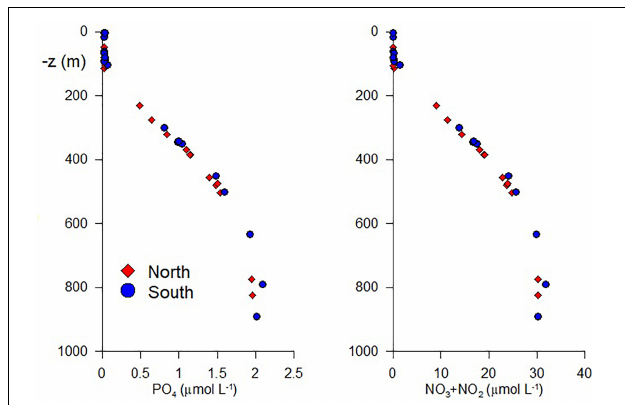
FIGURE 3 | Vertical profiles of inorganic dissolved nutrient concentrations of all CTD stations collated along the northern and southern flanks.